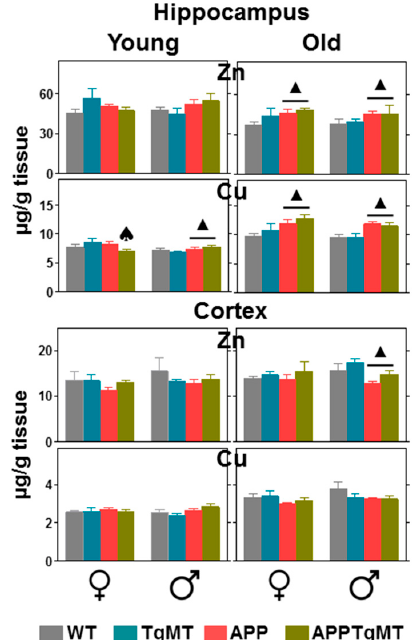
Figure 6. Effects of Mt1 overexpression on Zn and Cu levels. Total hippocampal ( top ) and cortical ( bottom ) homogenates from young (~6 months) and old (~14 months) mice were analyzed by ICP-MS. In the hippocampus, copper and zinc levels were increased and decreased by aging, respectively; both metals were increased in the cortex. APP and Mt1 expression showed different effects depending on the metal and brain area. Results are mean ± SEM ( n = 7–11); ▲ p at least ≤ 0.05 vs. APP negative mice. ♠ p < 0.05 interaction between APP and TgMT.